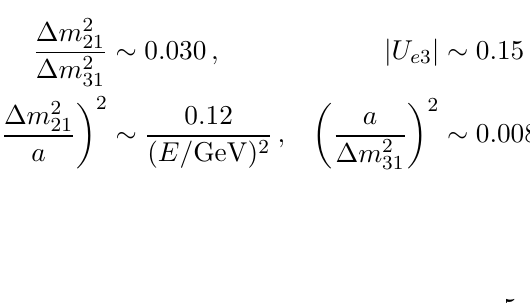
= sin (cid:14) , A T;CPT = sin (cid:22)e (cid:22)e